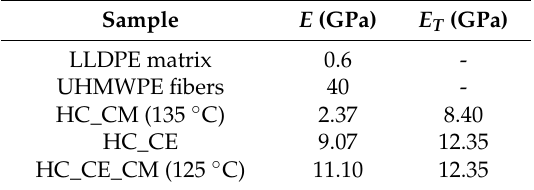
Figure 6. Stress–strain curves on LLDPE matrix, UHMWPE fibers, and homo-composites. Table 4. Tensile modulus of polyethylene homo-composites.